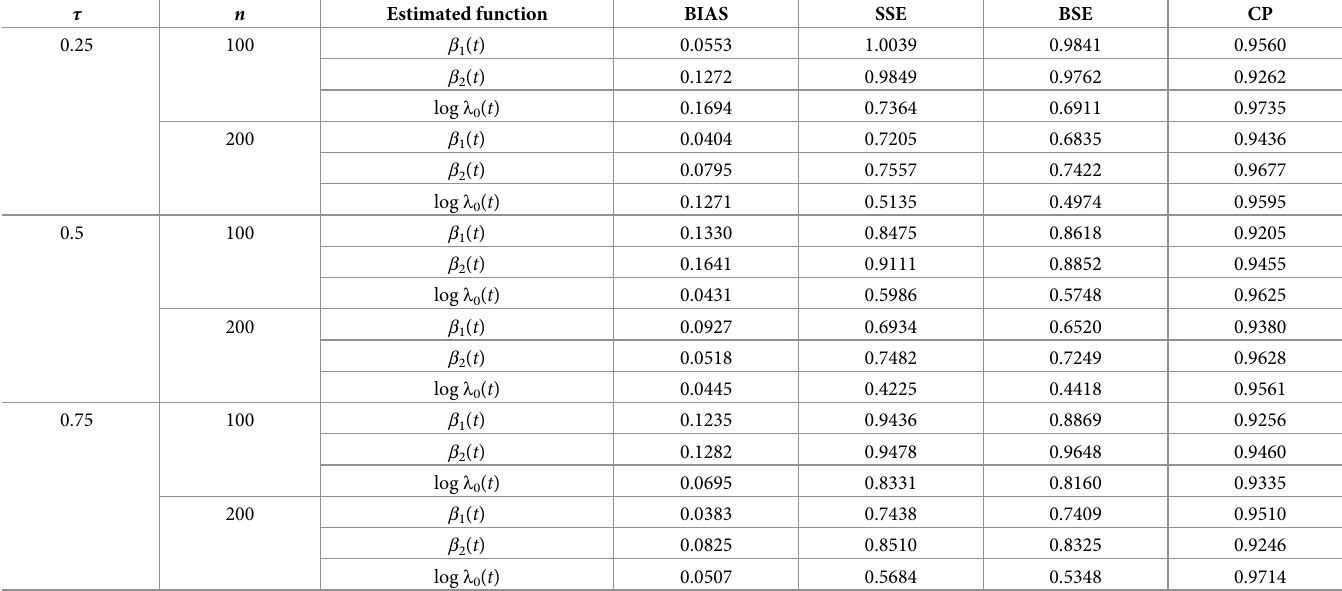
Table 3. BIAS, SSE, BSE and CP of the estimated functions in Case III at different τ . τ n Estimated